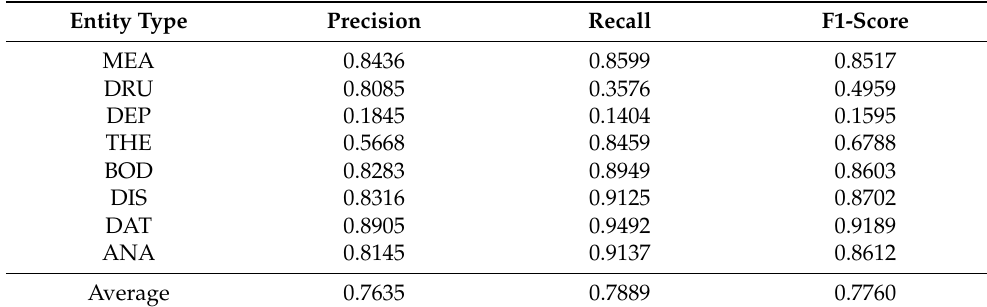
Table 7. Performance of the ELMo Bi-LSTM CRF at the last step of the AL phase of the annotation procedure, in terms of precision, recall and F1-Score for each class.